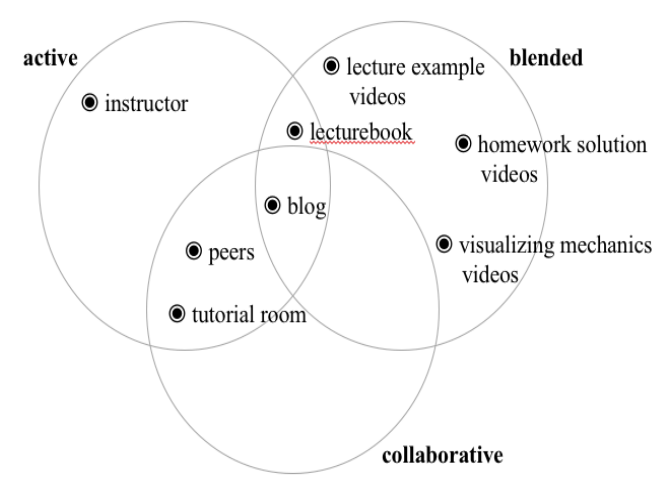
Fig. 1. A Venn diagram representation of the ABC learning resources available in the Freeform